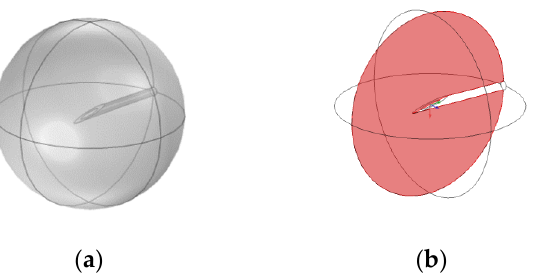
Figure 2. ( a ) Idealised tumour geometry with bevelled needle; ( b ) Cut plane through tumour, bisecting the needle along its shaft.